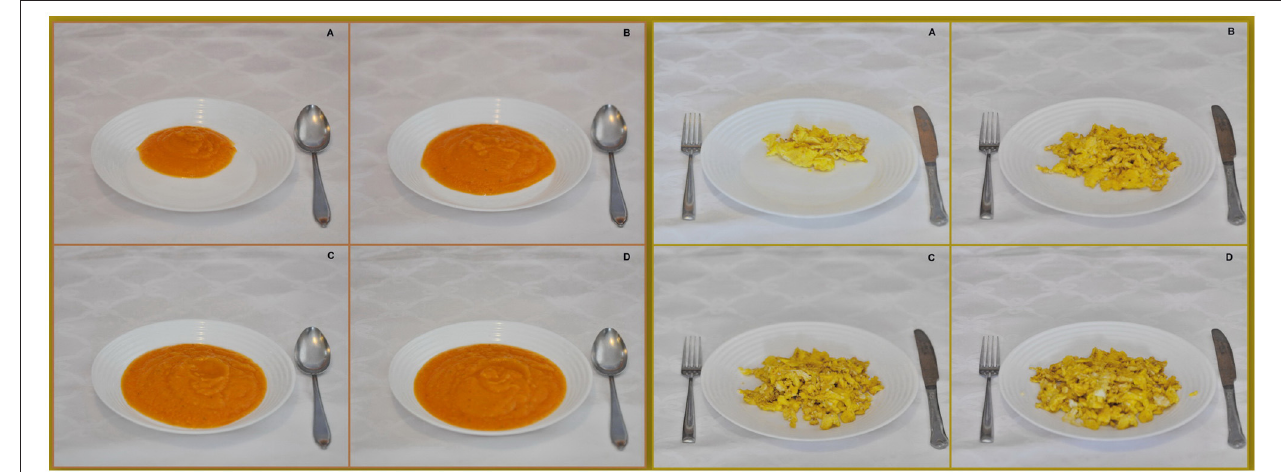
FIGURE 1 | Photo series of carrot soup (left) and scrambled eggs (right)